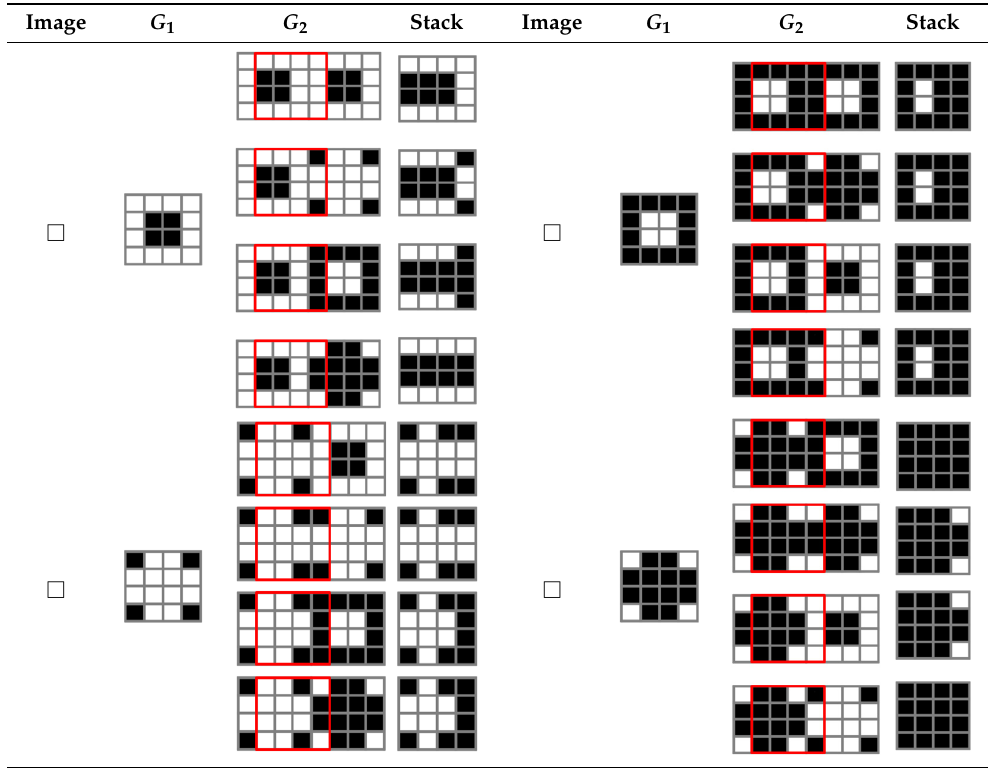
Table 7. The analysis of stacked units with one pixel shift when the pixel in the secret image is white.